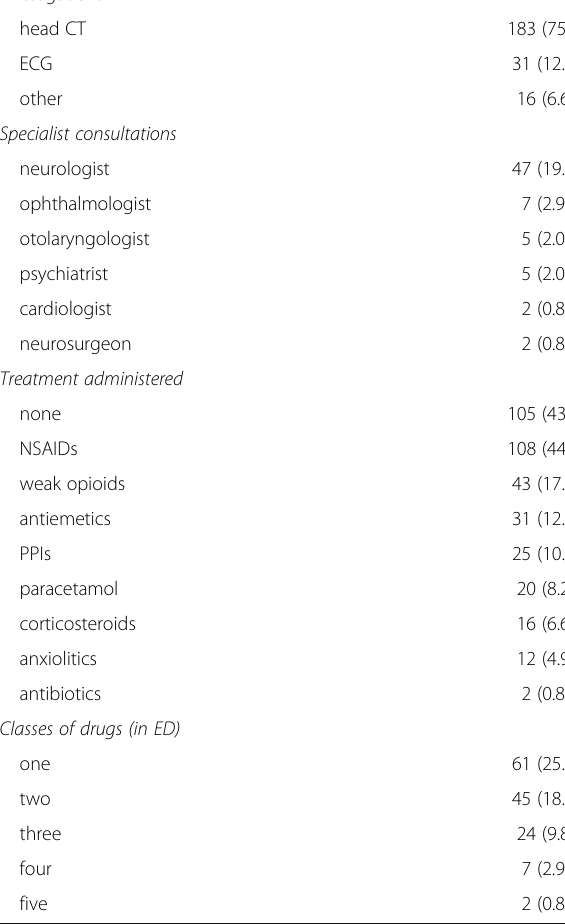
Table 3 Interventions in the emergency department Table 4 Factors that influence the length of stay in